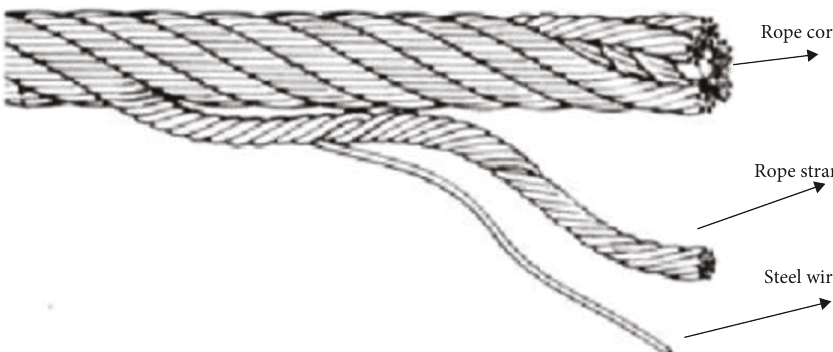
Figure 1: Wire rope structure.